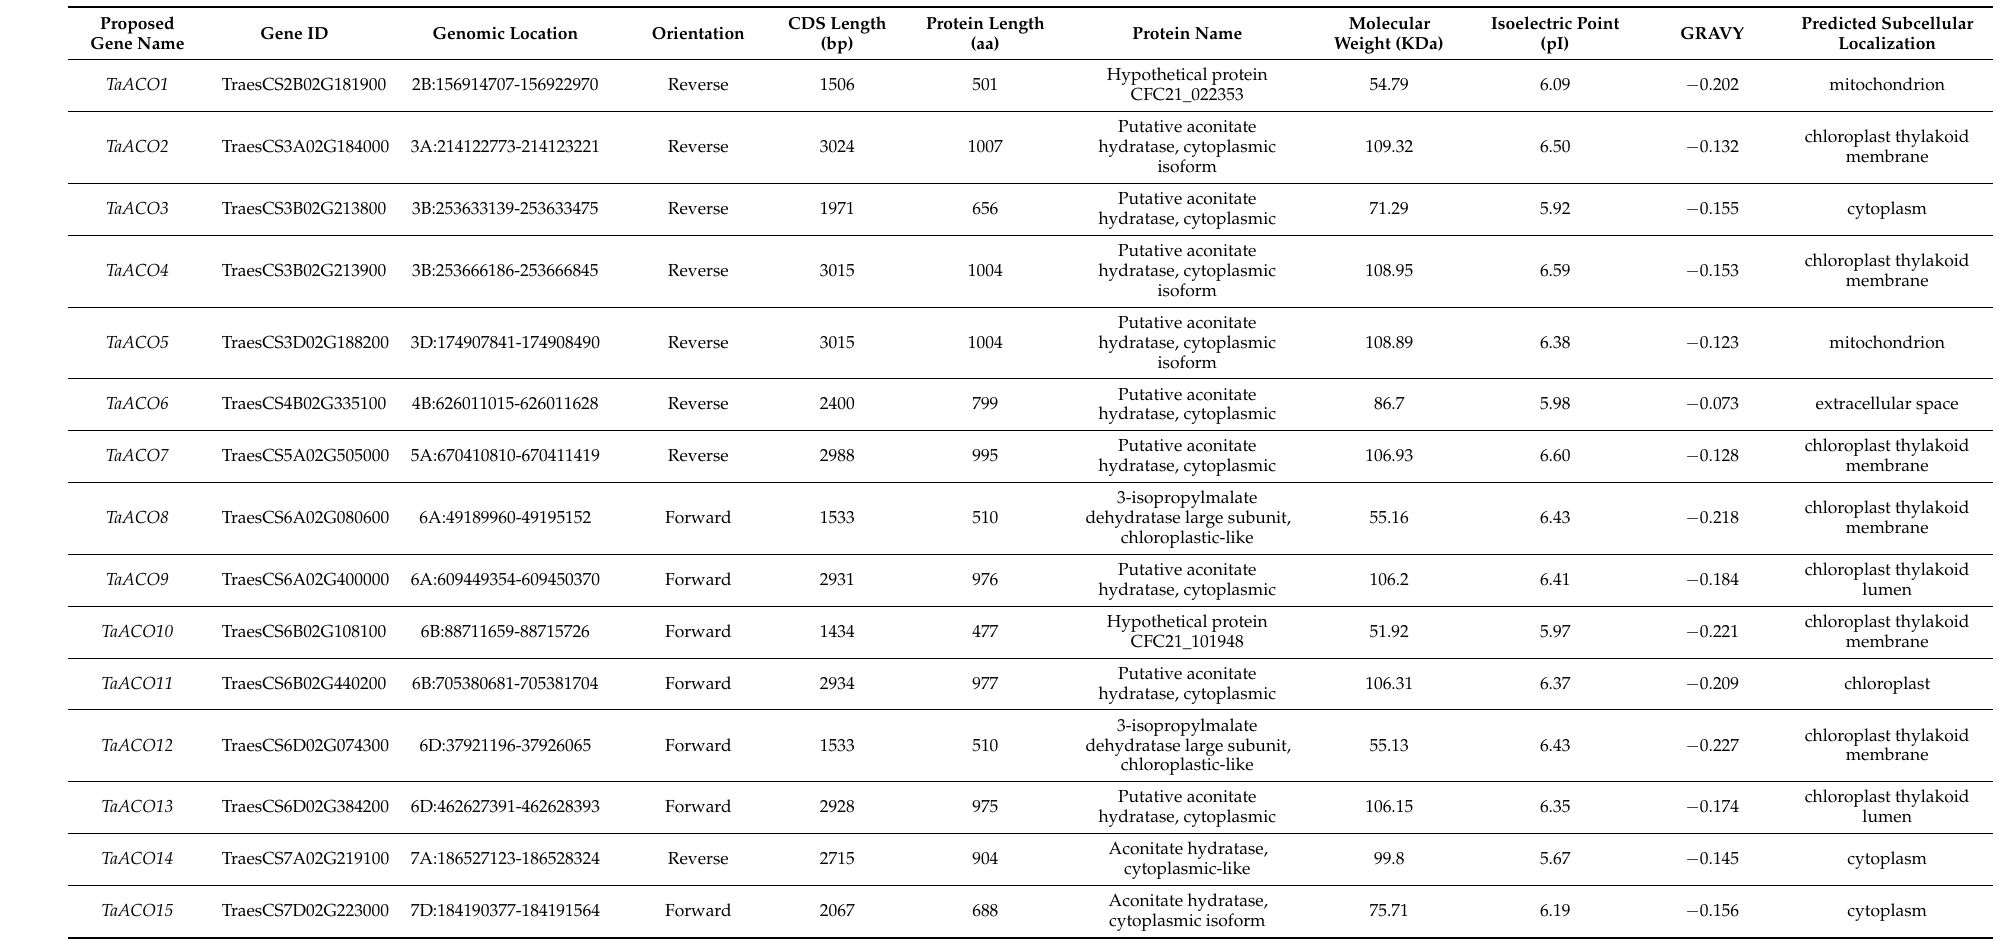
Table 1. Nomenclature and characteristics of the aconitase (ACOs) genes in wheat was detected using different computational